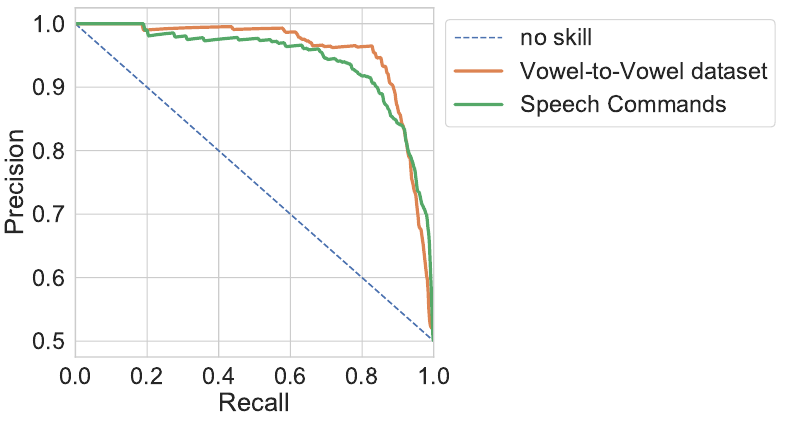
Figure 3. Precision vs. recall of the fine-tuned AWE model.